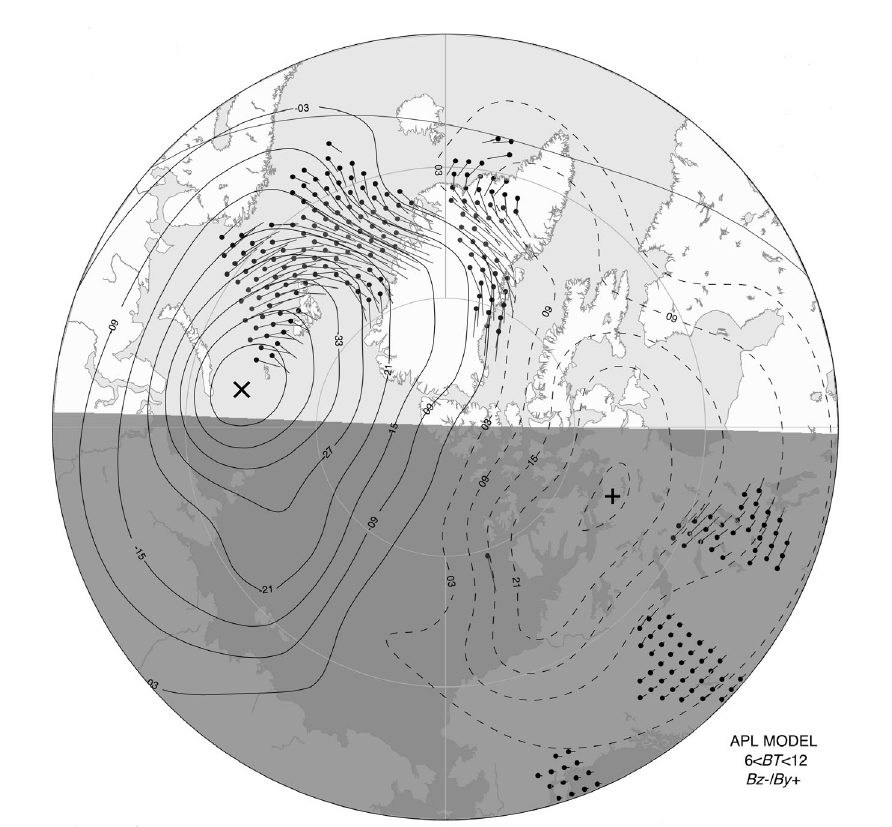
Fig. 14.10. Ionospheric convection flows estimated by the SuperDARN radars. 12:10 UT, 30th September 2003.